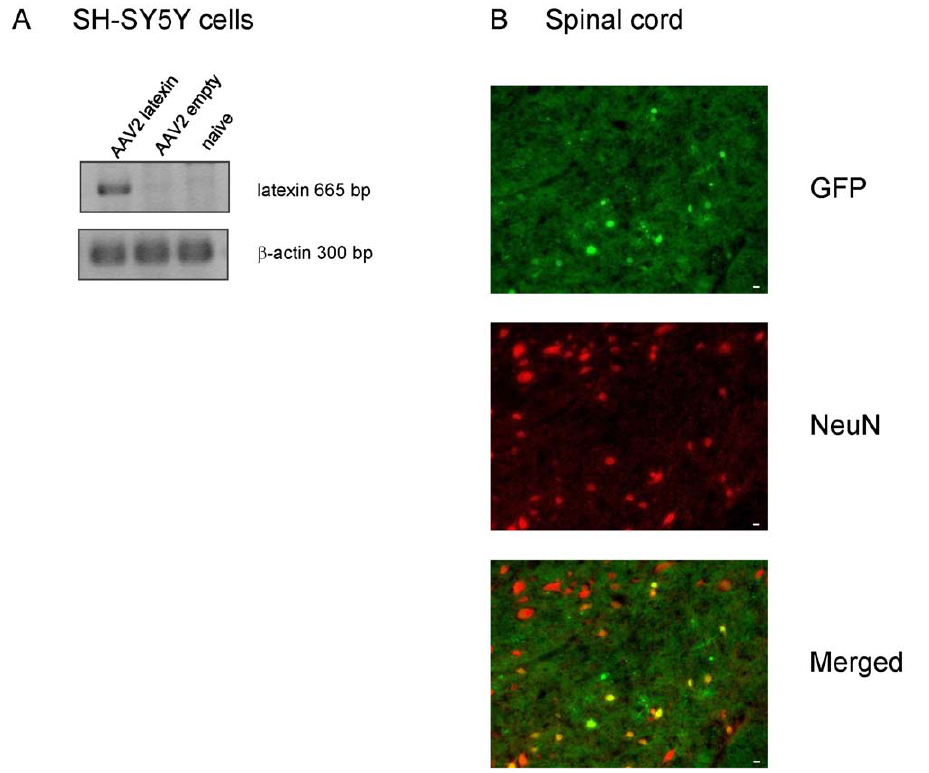
Figure 4. AAV-mediated overexpression of latexin. (A) RT PCR of latexin in SH-SY5Y neuroblastoma cells (naive or transduced with adenovirus with and without latexin) and (B) Spinal cord slices of mice 7 days after injection of AAV2 latexin virus. Upper panel: EGFP staining, middle; NeuN immunofluorescence, Lower panel Merged; Scale bar 10 m m.